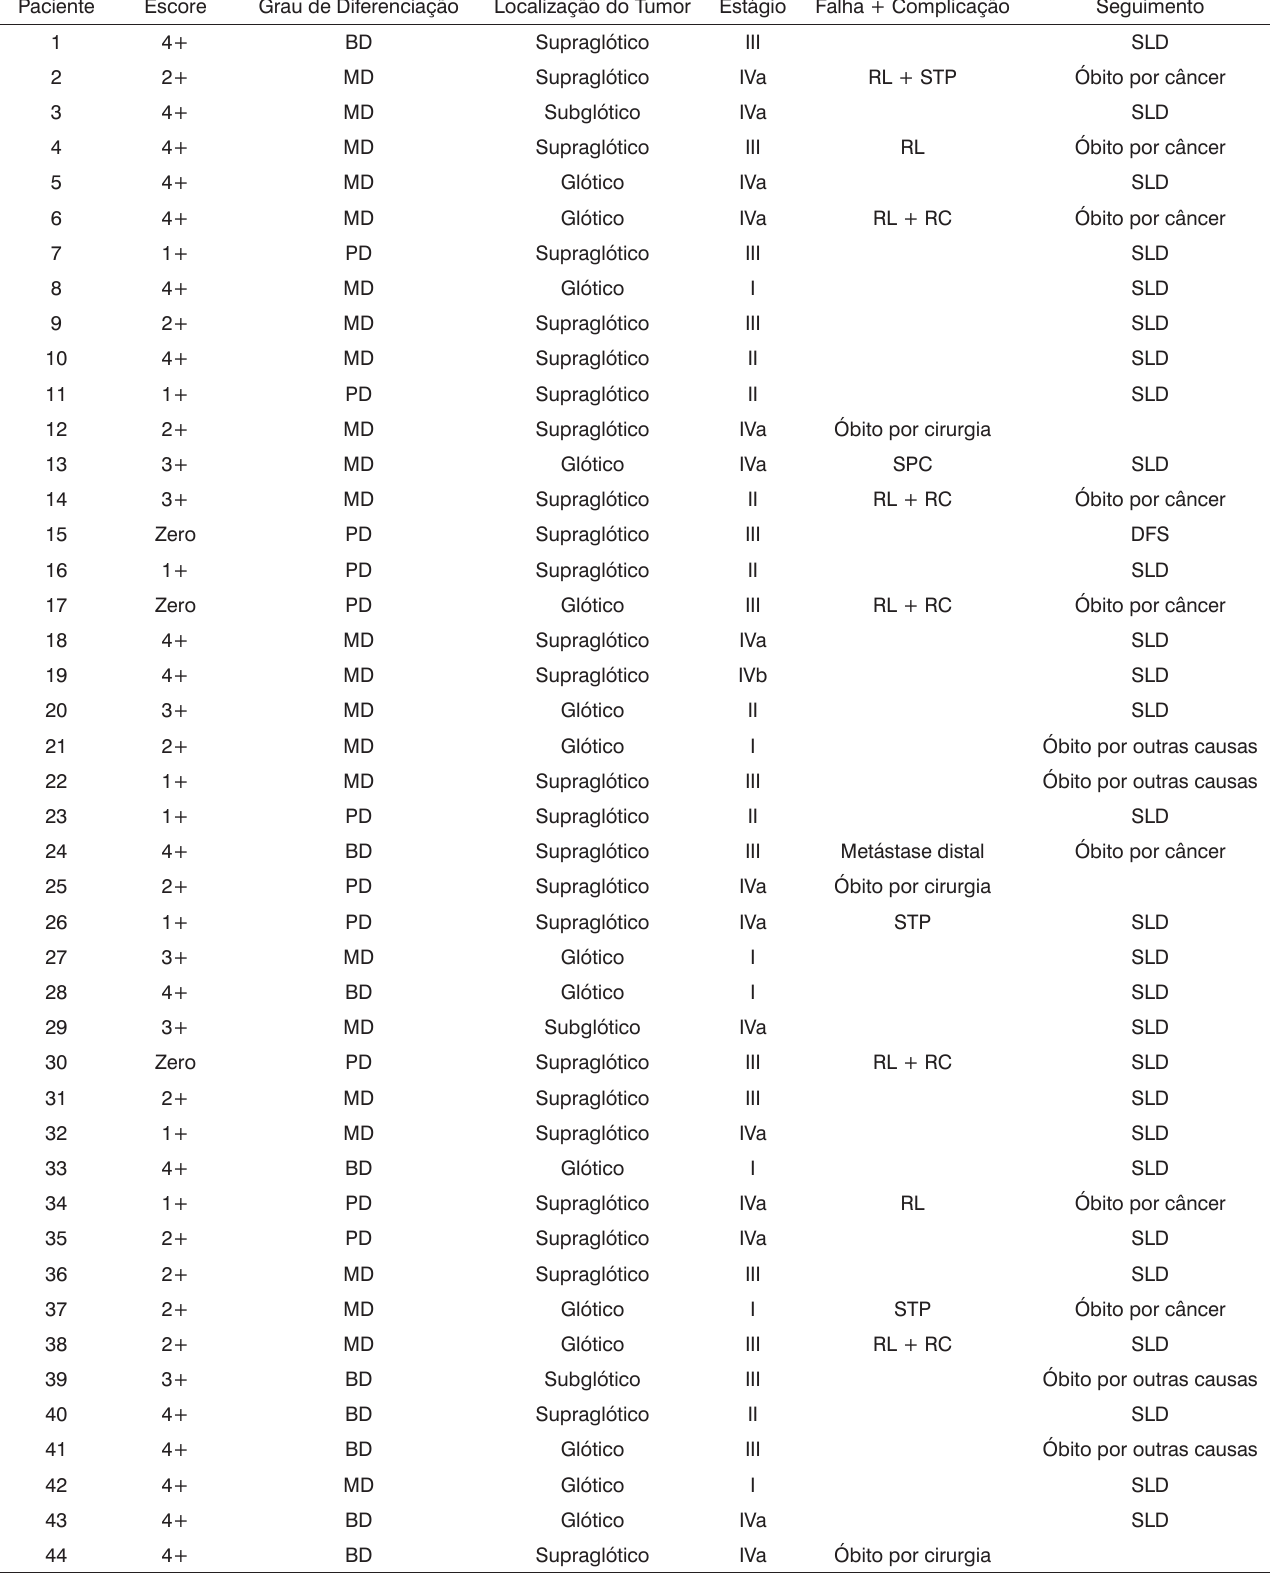
Tabela 1. Distribuição de escores, grau de diferenciação, localização do tumor, estágio, falha no tratamento e seguimento dos pacientes